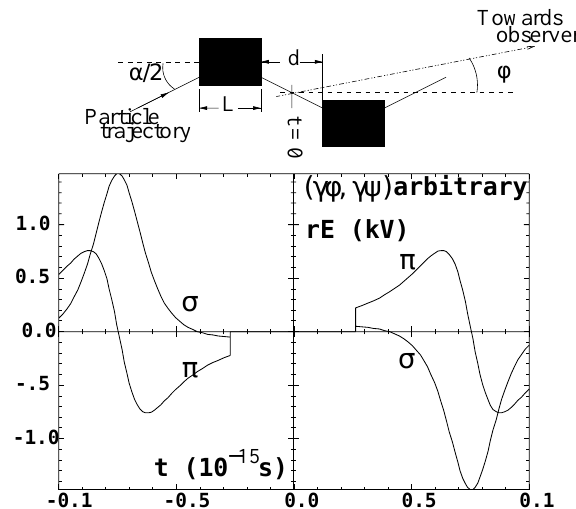
FIG. 2. Top: typical interferencial dipole doublet geometry. Bottom: typical shape of the electric field impulse from the two neighboring dipoles [Eq. (14)]. Both polarizations are odd functions of time whatever the observation direction (cid:1) gf , gc (cid:2)